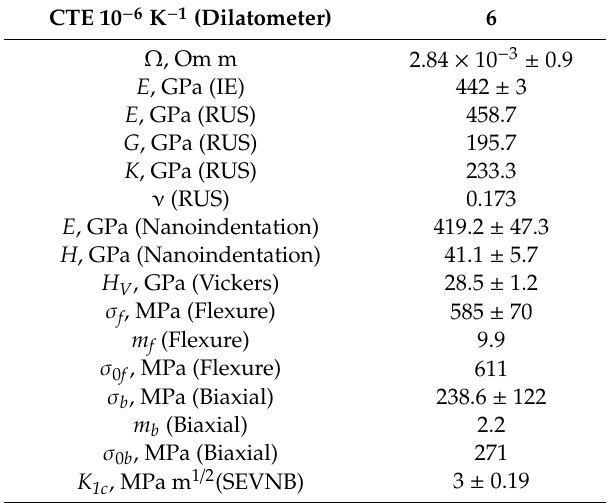
Table 1. Thermal, electrical and mechanical properties of B 4 C at room